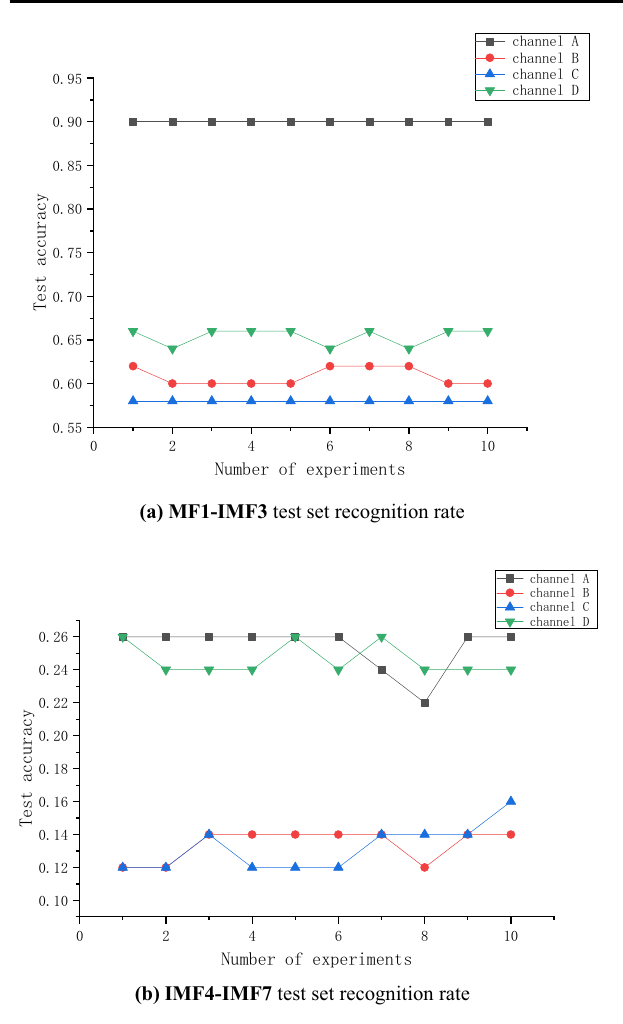
Fig. 6 Recognition rate of 4 channels with different feature values